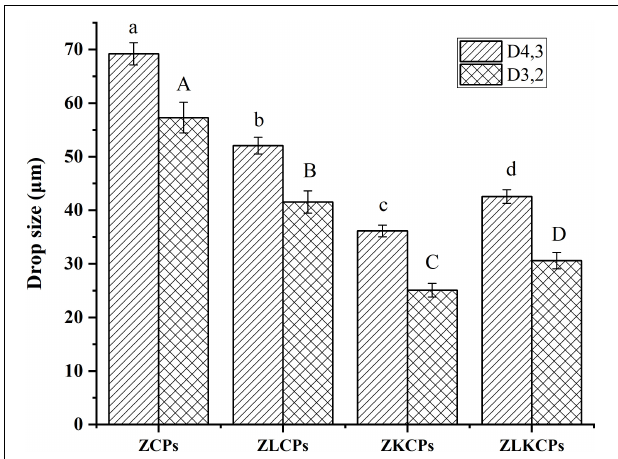
FIGURE 8 | Droplet size of Pickering